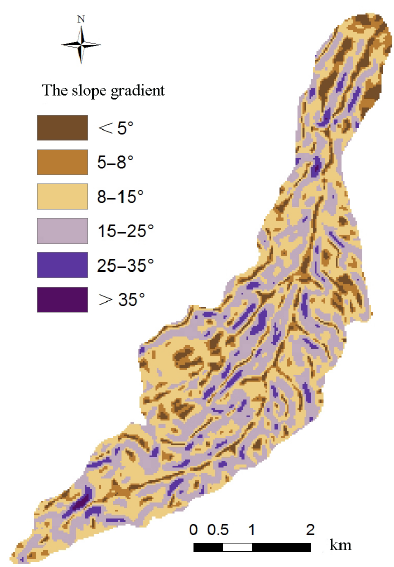
Figure 9. Spatial distribution of L factor values.